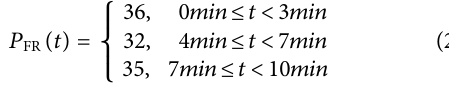
Frontiers in Energy Research |